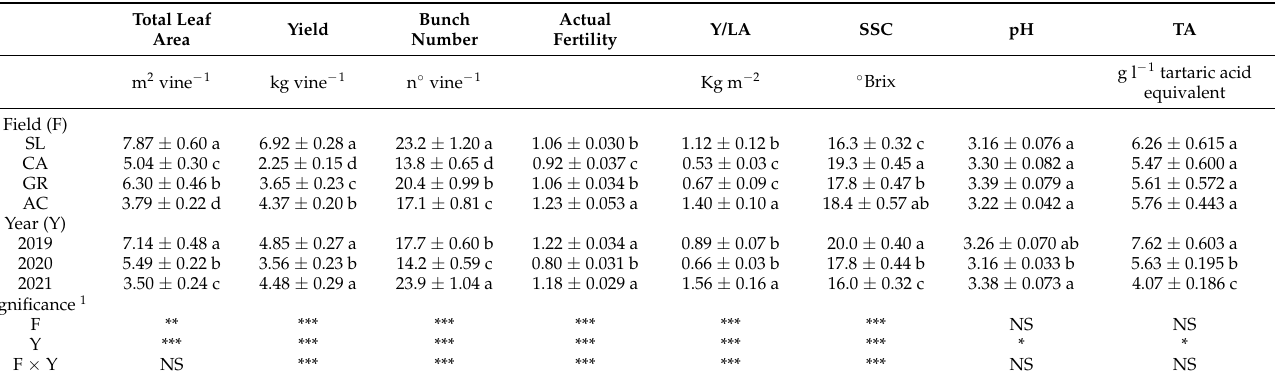
Table 1. Effects of field (F), year (Y), and their interaction (F × Y) on total total leaf area, yield, bunch number, actual fertility, Y/LA, SSC, pH, TA, of V. vinifera subsp. vinifera “Falanghina” vines at the four study sites: SL-Santa Lucia, CA-Calvese, GR-Grottole, and AC-Acquafredde. Mean values and standard errors are shown. Different letters within each column indicate significant differences according to Duncan’s multiple-range test ( p ≤